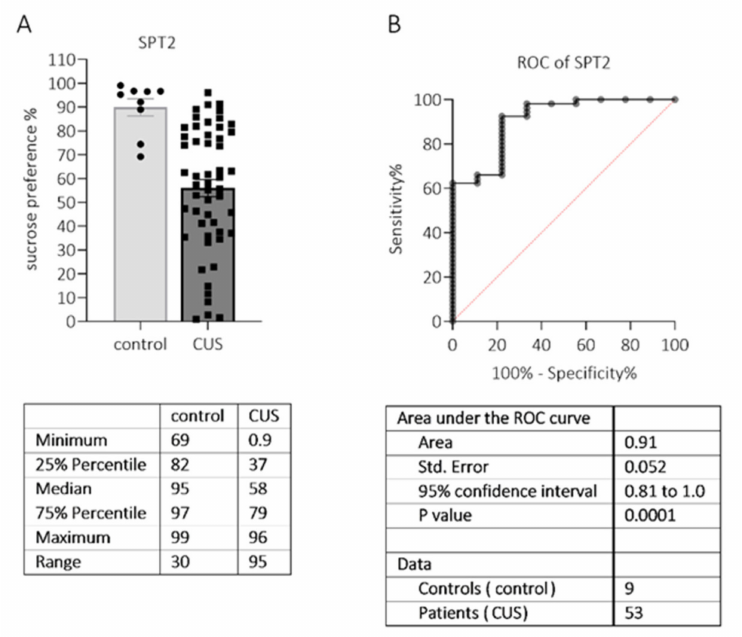
Figure 3. The results of the sucrose preference test (SPT2) after CUS procedures in rats. Control animals ( n = 9) were living under standard vivarium conditions, while stress-exposed animals (CUS, n = 56) were housed individually and exposed to unpredictable stressors (two a day) for 26